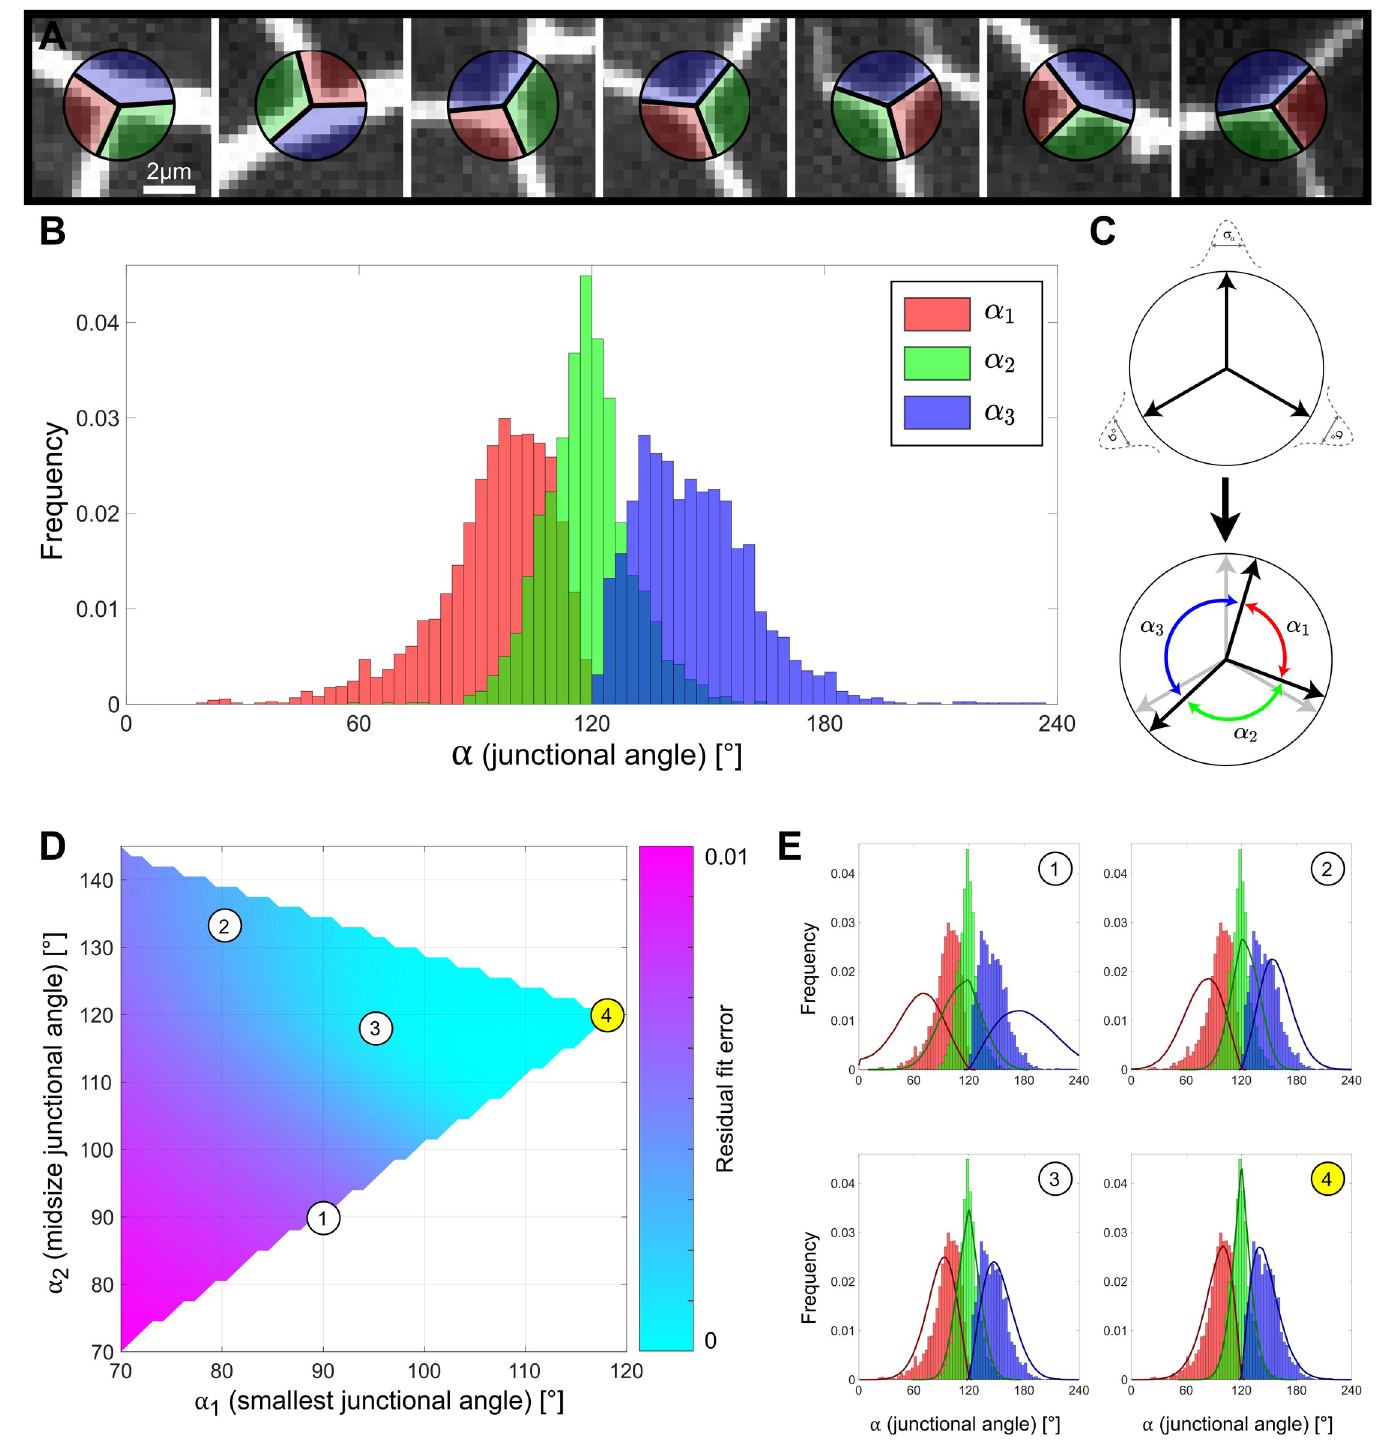
Fig 5. The geometry of PVD junctions. A. Examples of various PVD junction morphologies. Colors correspond to relative junctional angle size: smallest (red, α 1 ), mid- size (green, α 2 ) and largest (blue, α 3 ). B. Each junction is described by three angles, corrected for distortion due to projection. The distributions of the smallest (red), mid- size (green) and largest (blue) angles are shown (n = 10 animals; 2620 junctions). The mean values of the angle distributions are 92˚, 119˚ and 149˚. C. A cartoon showing the effect of random variations in junction configuration. An intrinsic junction configuration (top) is deformed, resulting in one of the possible deformed configurations (bottom). D. Fit of Monte Carlo simulated angle distributions with the experimental distributions. The best fit to the experimental data is for a symmetrical configuration